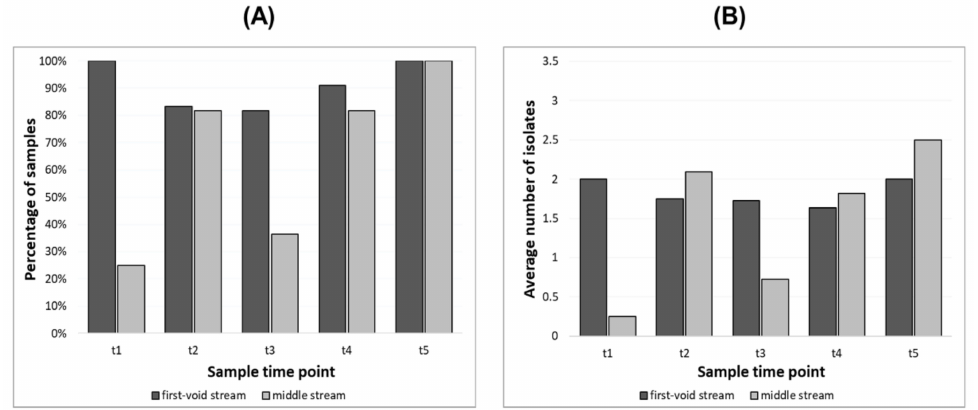
Figure 2. ( A ) The percentage of samples from which bacteria were isolated at the variable time points. ( B ) The average number of isolates isolated from individual urine samples at the variable time points. Variable time points: t1—before gold fiducial implantation into the prostate gland, t2—before radiotherapy, t3—at the end of radiotherapy, t4—1 month after radiotherapy, t5—4 months after radiotherapy.